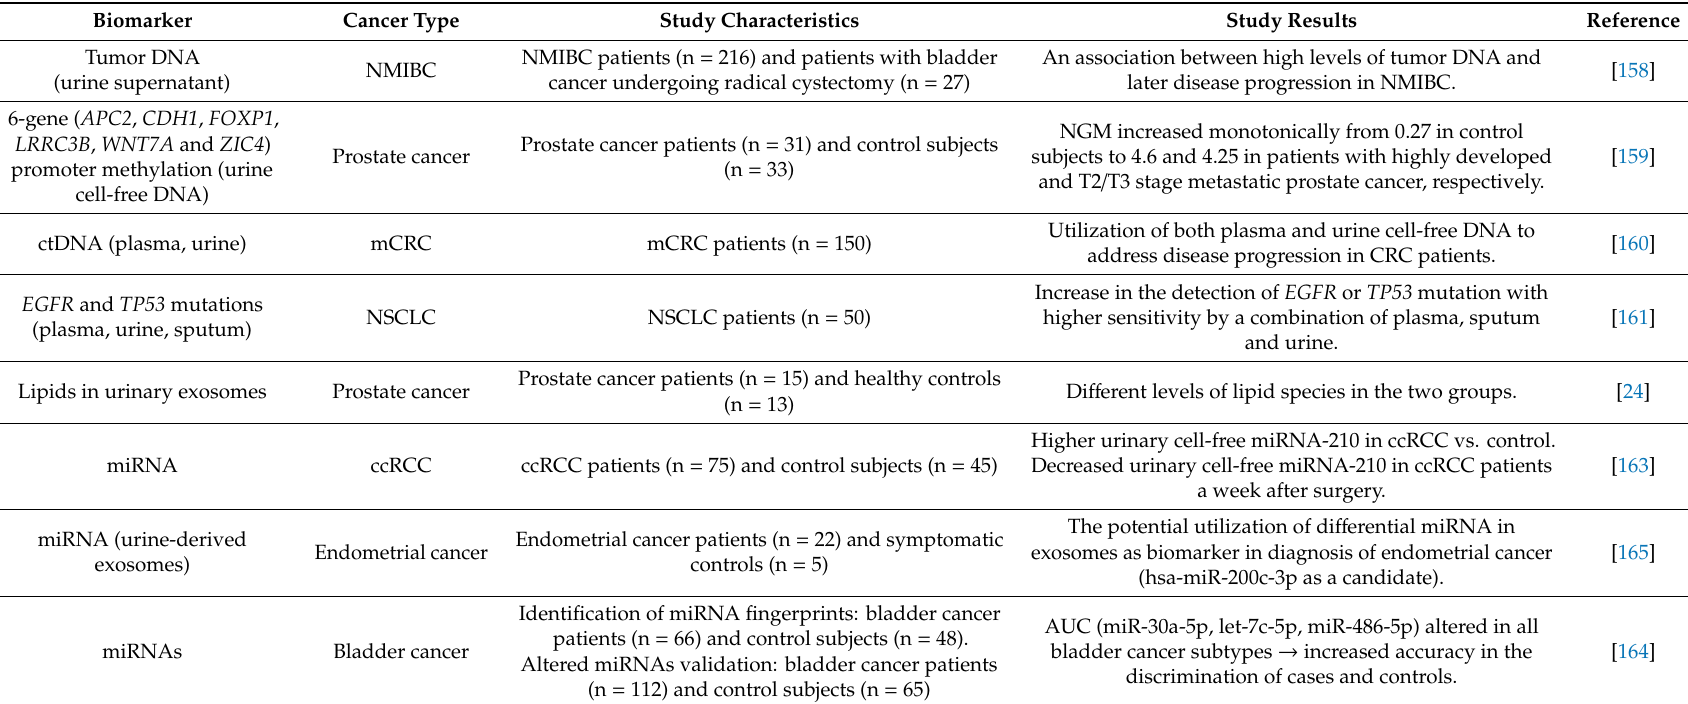
Table 3. Potential role of cancer biomarkers in liquid biopsy performed on urine